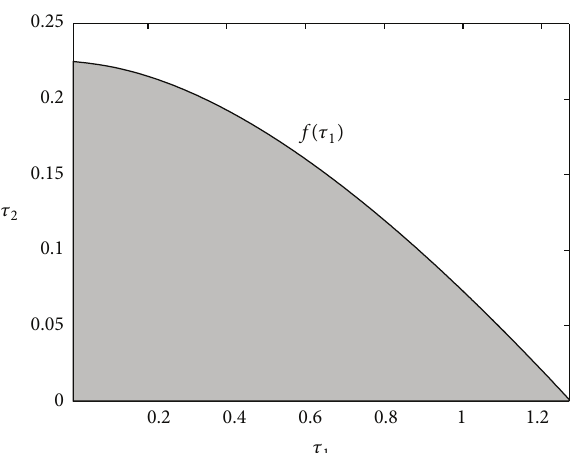
Figure 3: The critical curve of stable domain with respect to 𝜏 1 and 𝜏 2